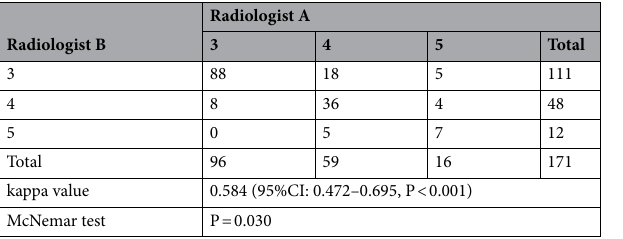
Table 2. The PI-RADS v2.1 score between Radiologist A and Radiologist B. Note. The assessment of PI-RADS v2.1 was performed by two radiologists, a junior with 5 years of experience (Radiologist A) and a senior with more than 20 years of experience (Radiologist B) in urogenital imaging.